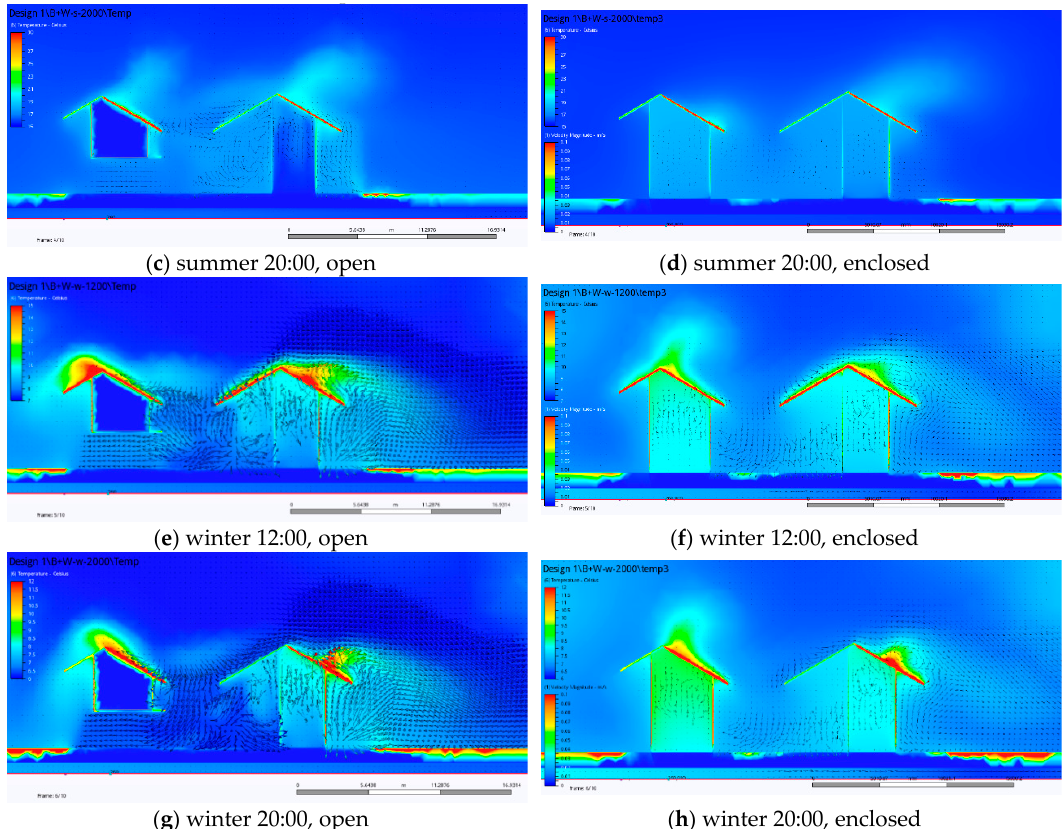
Figure 26. Air temperature distribution by both wind and buoyancy effects: ( a – d ) summer scenarios , and ( e – h ) winter scenarios .